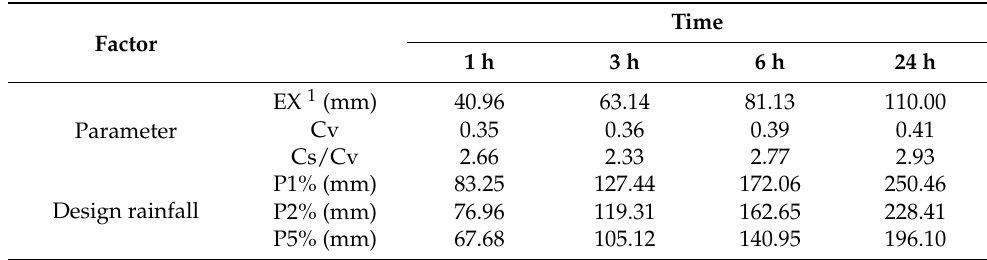
Table 3. Occurrence probability distribution parameters of rainfall and design rainfall with different return period.